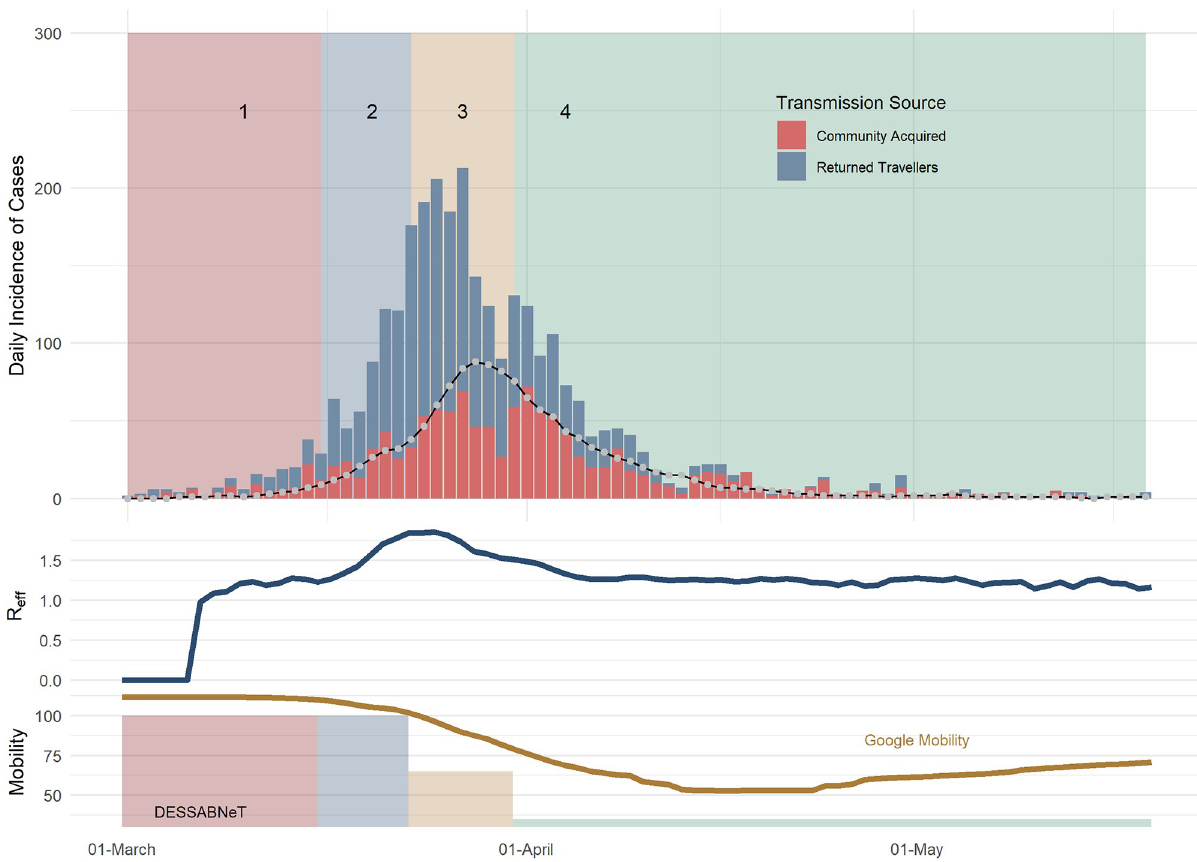
Fig 2. Sydney daily incidence of COVID-19 cases (bars) and simulated daily incidence of symptomatic community transmission cases (line), with the simulated daily R shown in the middle plot. The line in the top plot is the simulated total incidence. The rates of working from home used in our eff simulation corresponds to Google mobility (workplace) measures.